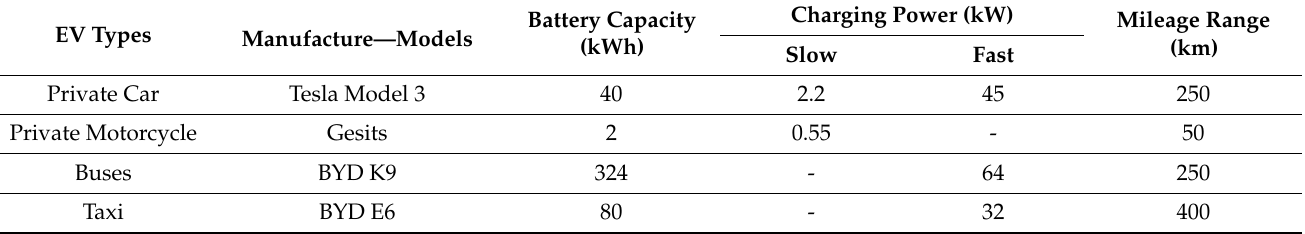
Table 2. Electric vehicle